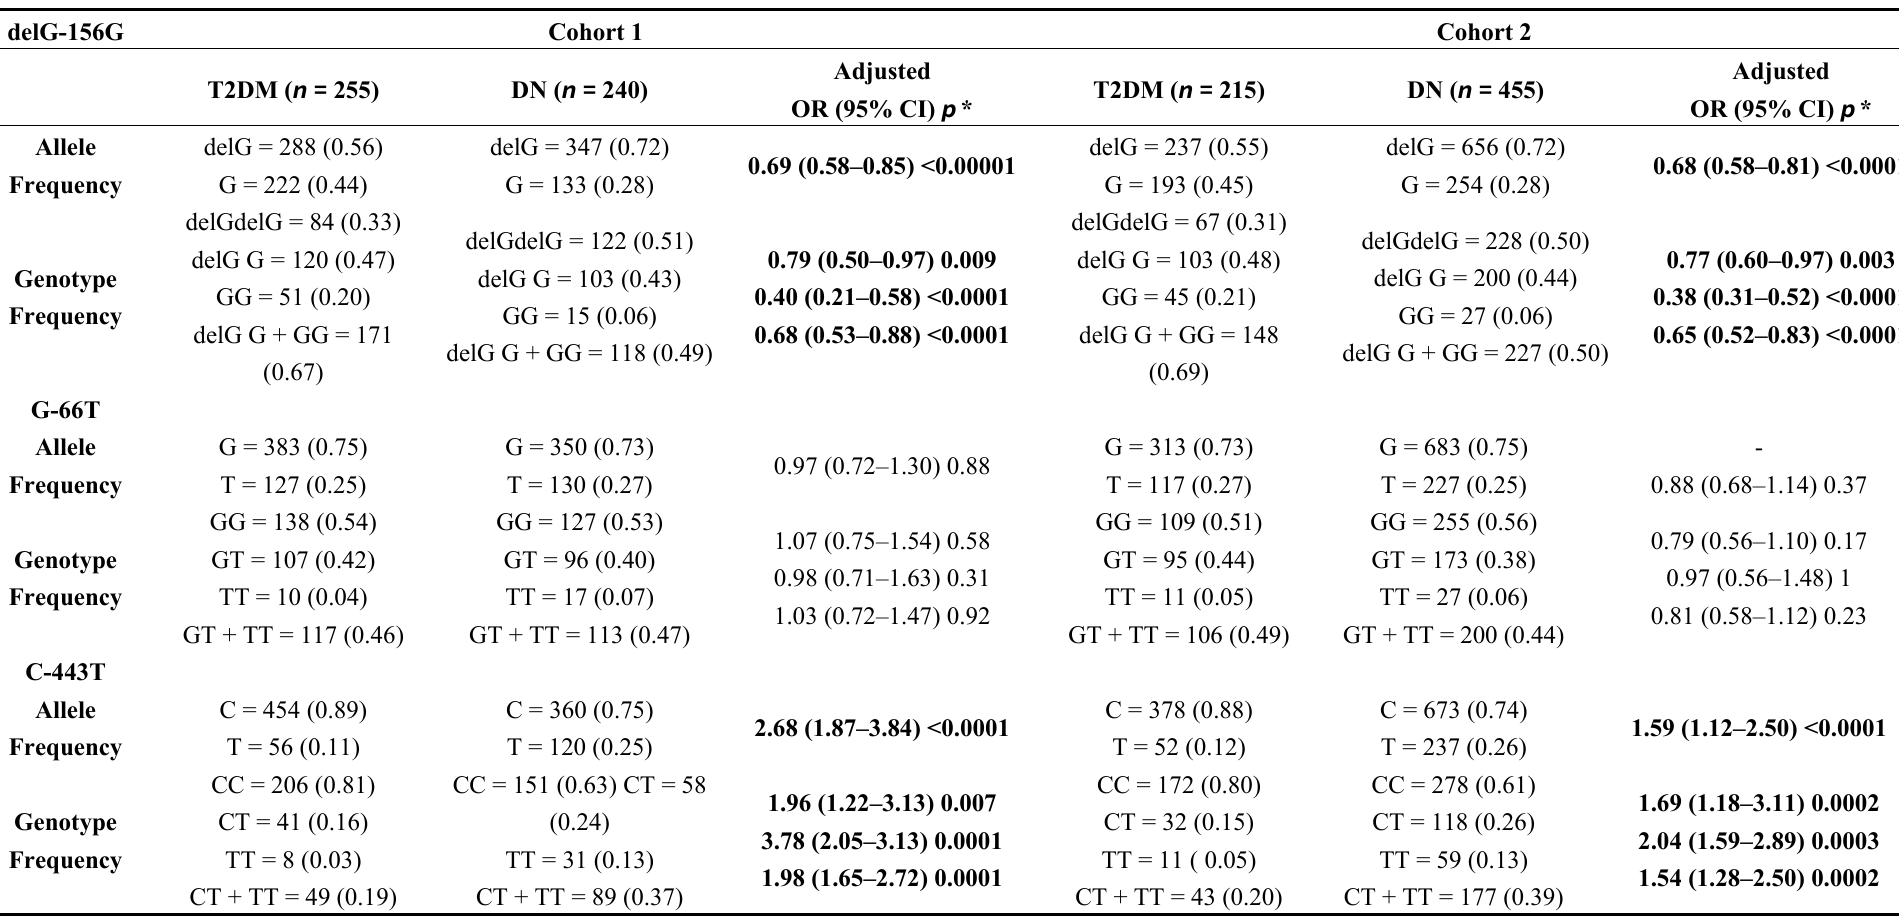
Table 1. Allele and genotype frequency of OPN gene promoter polymorphism in subjects with type 2 diabetes mellitus (T2D) vs. diabetic nephropathy